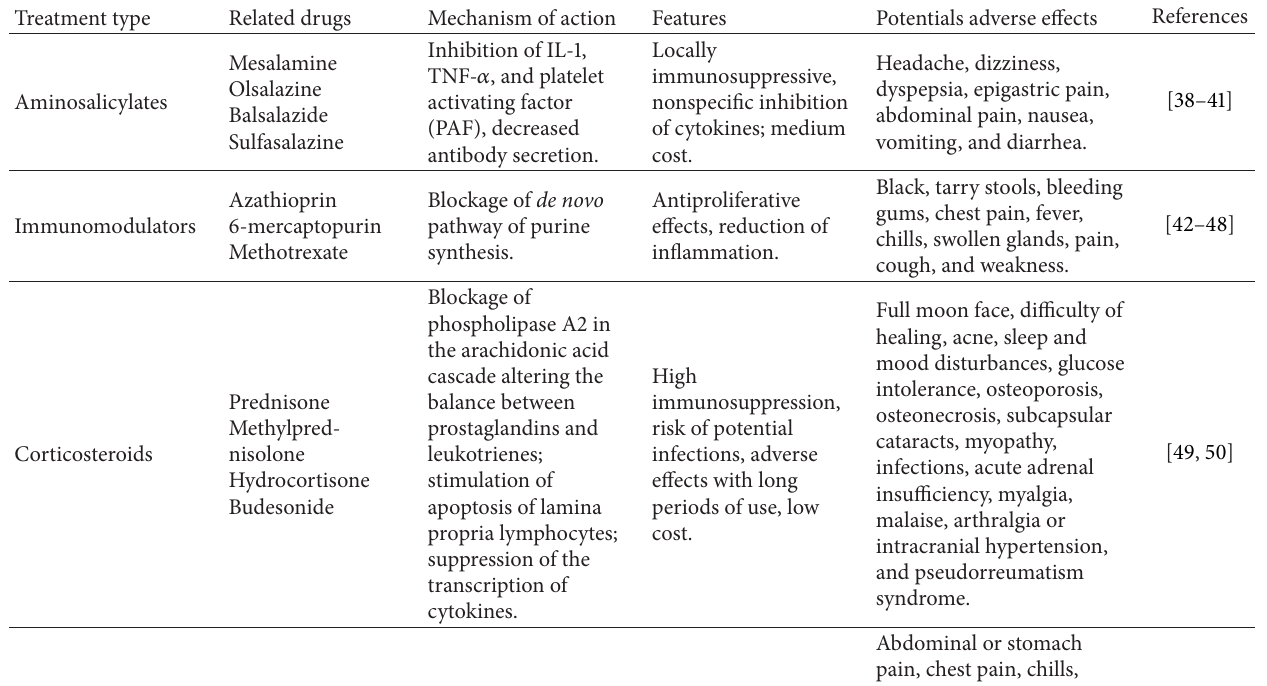
Table 1: IBD treatments: drugs in use, mechanisms of action, and side